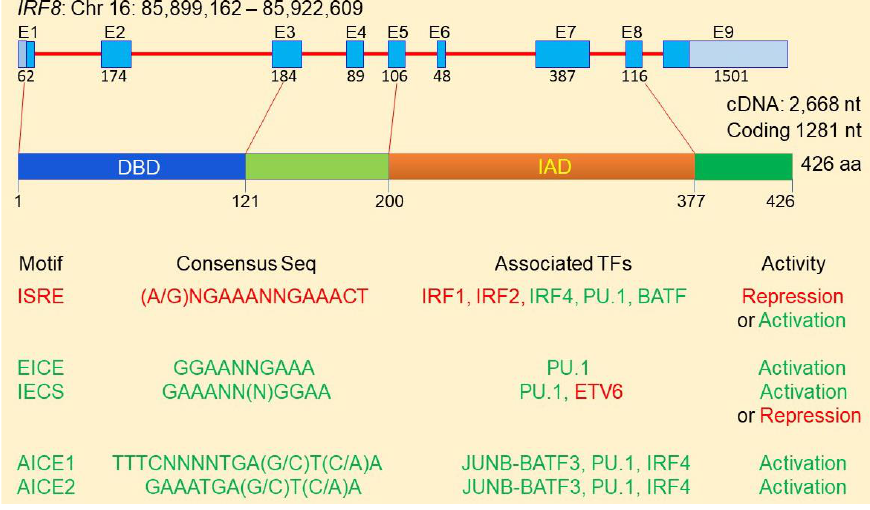
Figure 1. The IRF8 protein structure and transcription regulatory network.